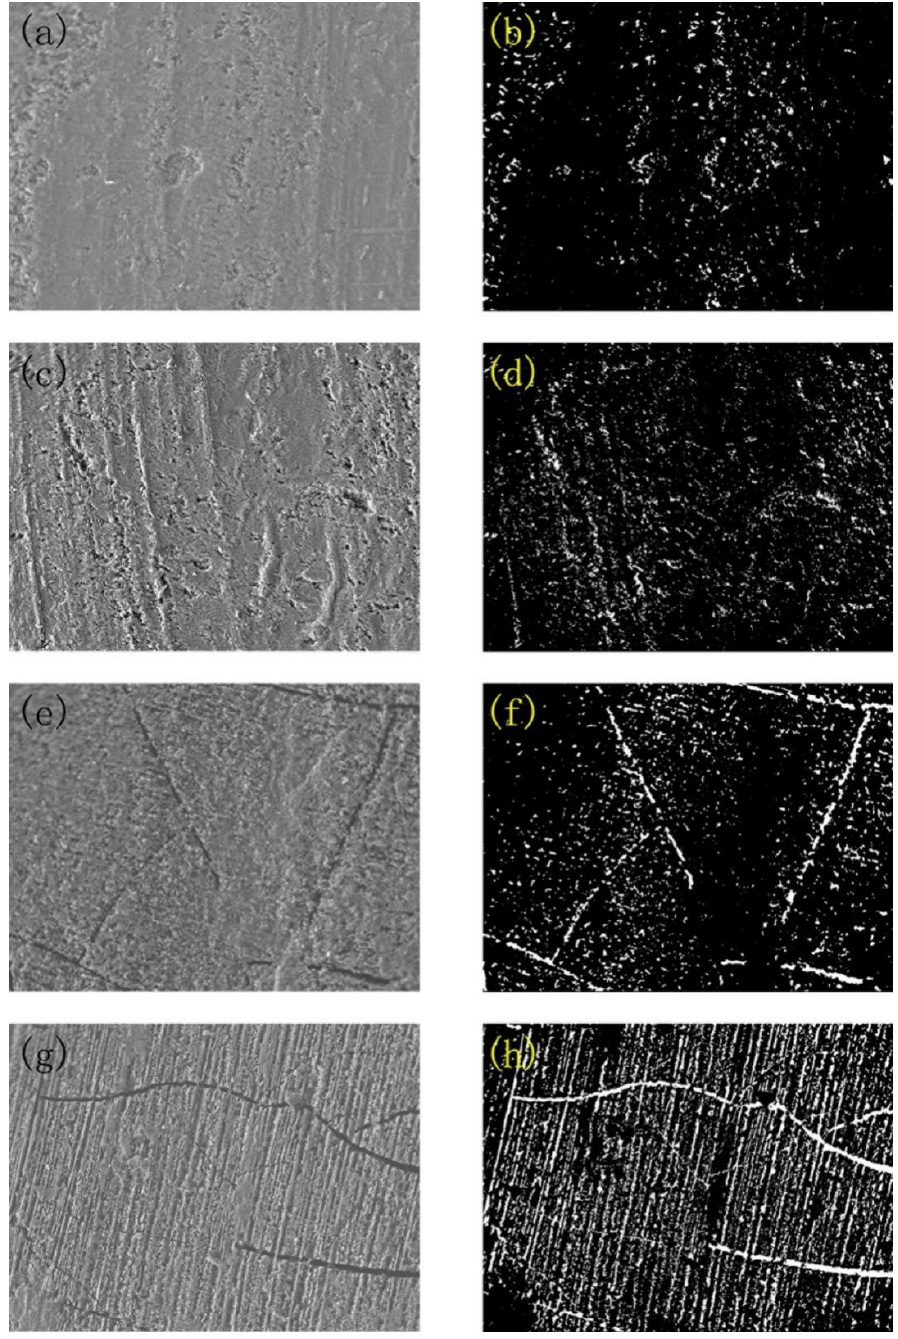
Figure 2. Micro surface structure of SEM image and its porosity analysis by Image J software on anodic coating treated by hydro-thermal technology at ( a , b ) 200 °C, ( c , d ) 300 °C, ( e , f ) 400 °C, and ( g , h ) 500